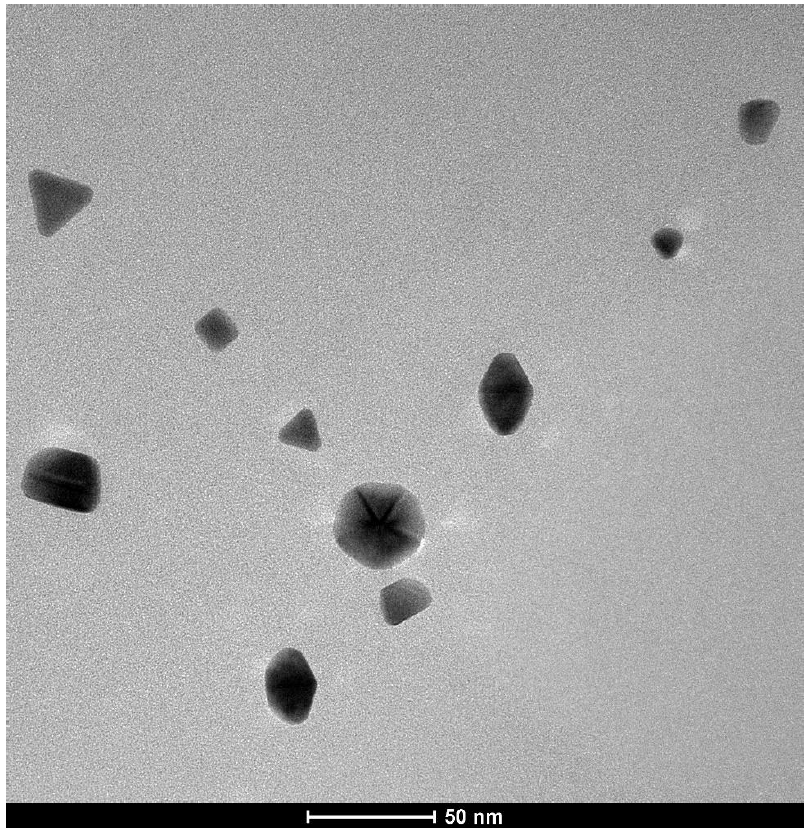
Figure 3. TEM image of gold nanoparticles formed in BSA.